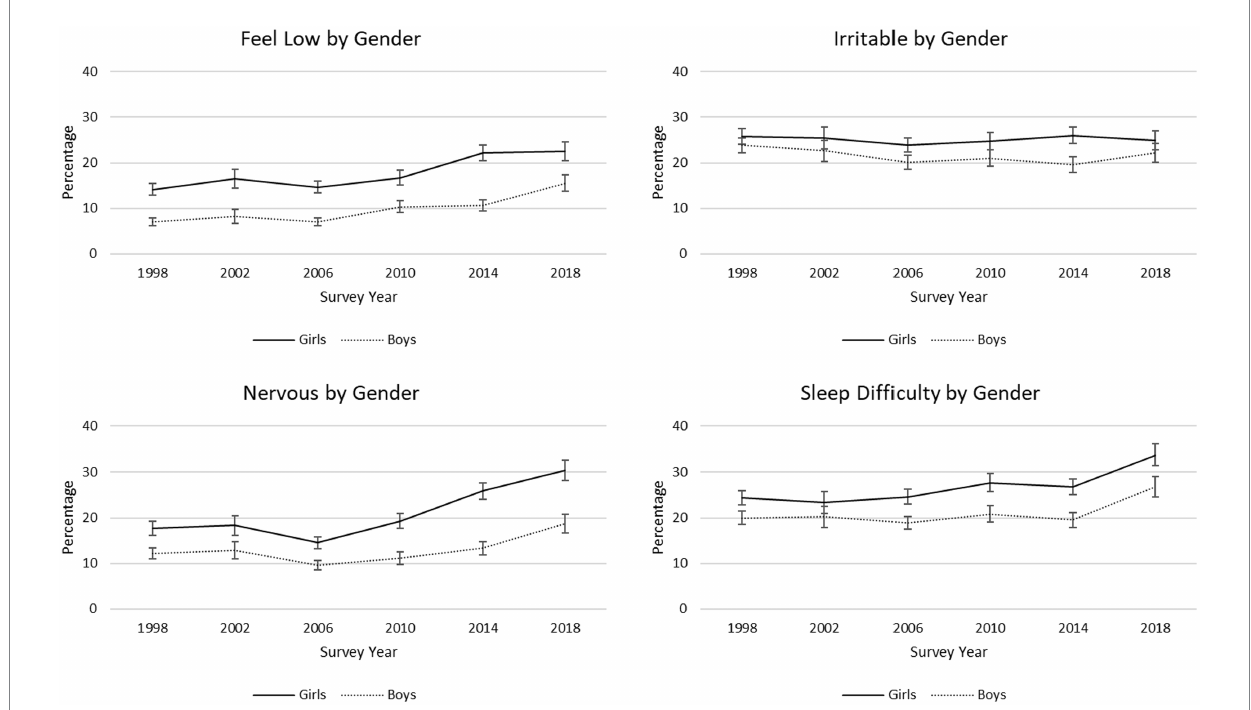
FIGURE 2 Trends in percentages of reported psychological symptoms, by gender. 95% confidence intervals are depicted.